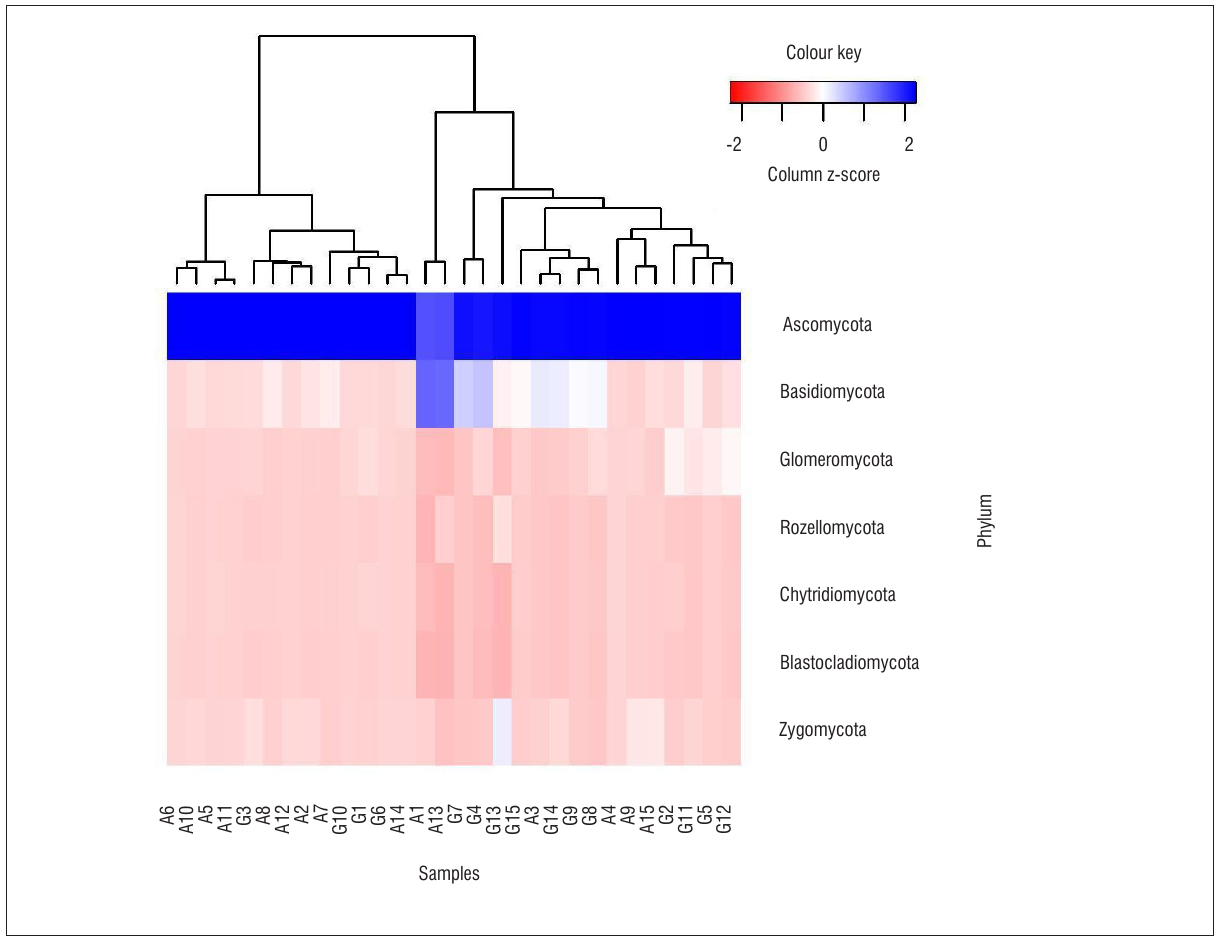
Figure 3: Heatmap displaying the fungal phyla detected. Paired-site samples are clustered based on the per cent relative abundance. Each row was scaled so that the mean of each taxonomic group across samples was calculated and coloured by the corresponding z-score of each cell. Sample names starting with A were obtained from agricultural soils while those starting with G were from grassland